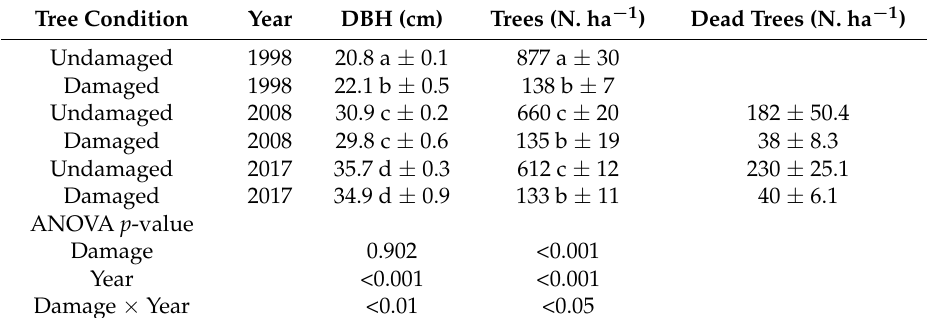
Damage 0.902 <0.001 Year <0.001 <0.001 Damage × Year <0.01 <0.05